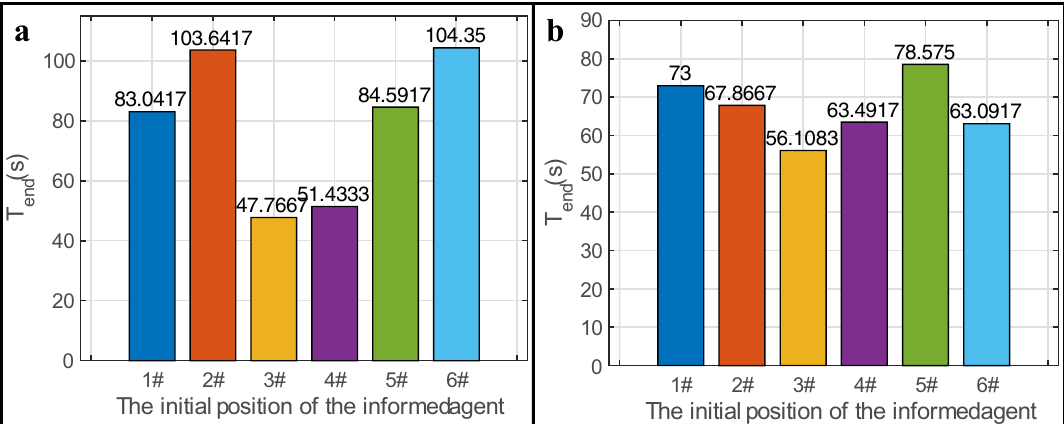
Fig. 11 Time it takes for the drone swarm to traverse the typical scenario in experiment. a The task completion time of the non-AGDS flocking algorithm when the informed agent is in different positions. b The task completion time of the AGDS flocking algorithm when the informed agent is in different positions